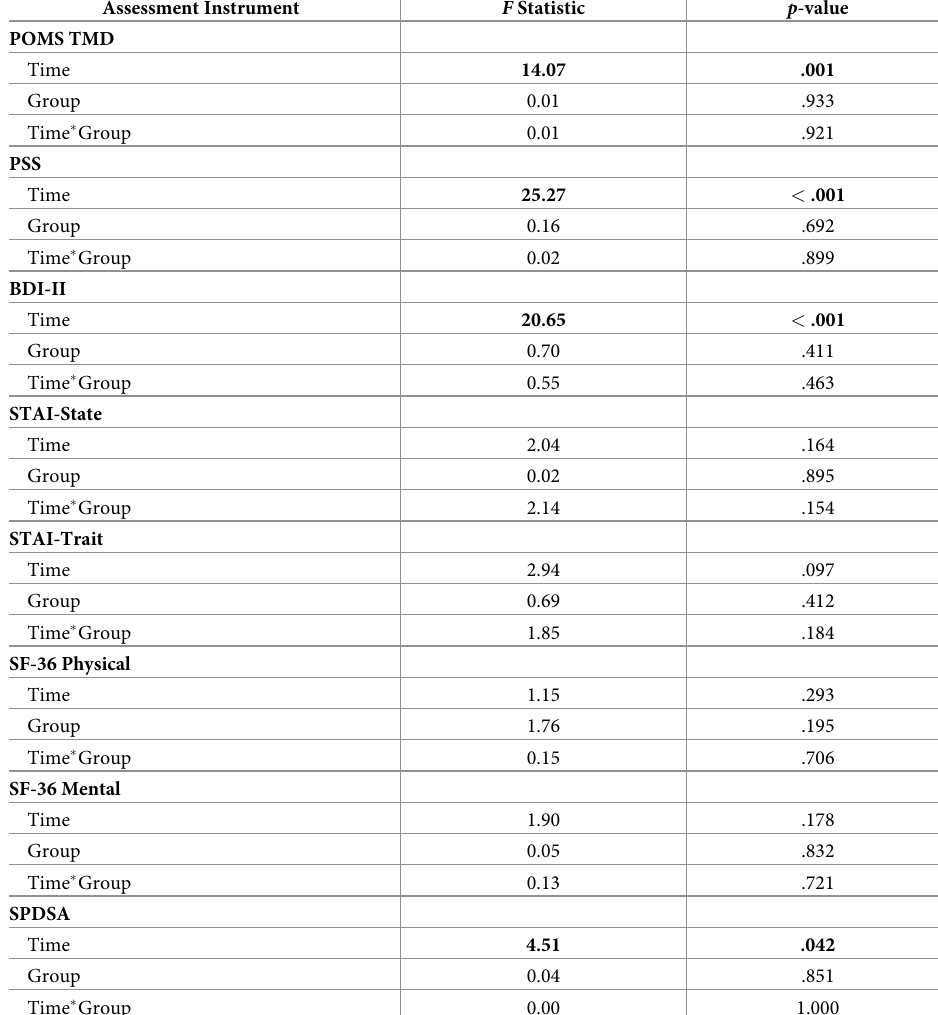
Table 4. F -Test table from a two-way repeated measures ANOVA with Bonferroni correction for comparisons within each psychometric instrument